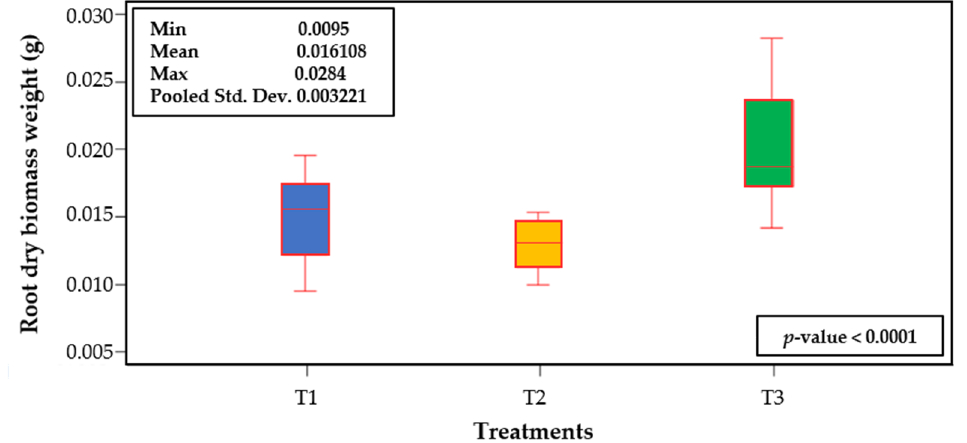
Figure 4. Box diagram of root dry biomass weight of lulo ( Solanum quitoense Lam.) seedlings grown in different combinations of peatmoss and compost. Data of 10 seedlings per treatment, randomly selected, one per repetition. Wilcoxon’s rank summation test ( p ≤ 0.05). Treatments are as follows (percentage of peatmoss/compost, v / v ): T1: 60/40; T2: 40/60; T3: 20/80.